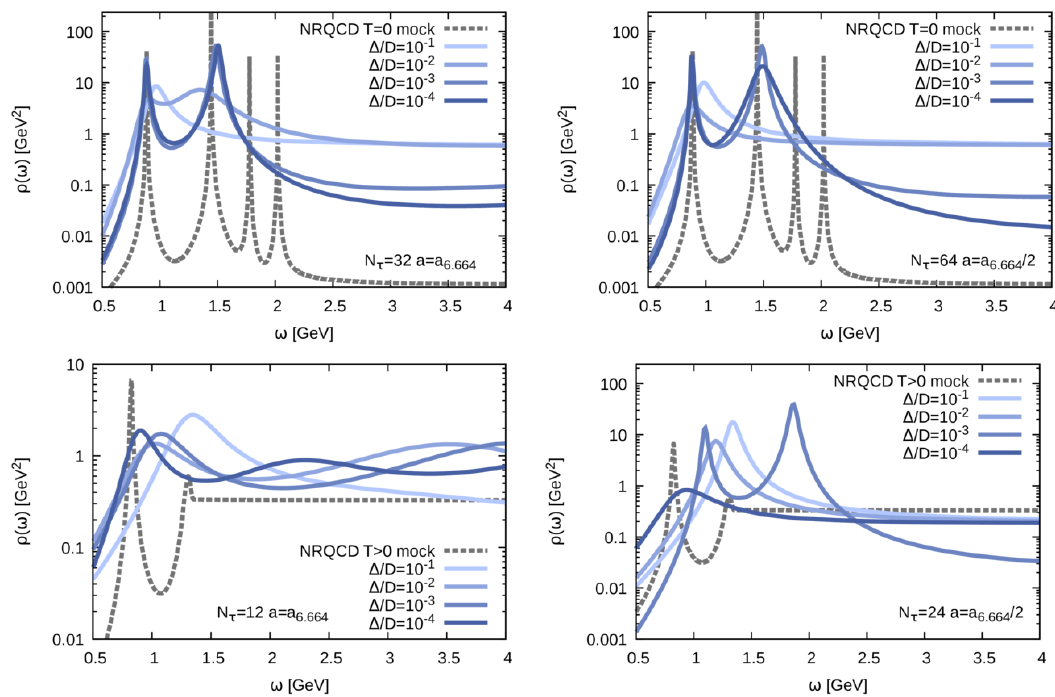
Figure 25 . Mock data tests on the prospects for improving spectral reconstruction by going closer to the continuum limit. In the top row we show a T = 0 mock test with the mock spectrum (dashed gray) consisting of four sharp Breit-Wigner peaks ordered according to the PDG (cid:7) channel masses. The lowest peak is located at the frequency found in the raw NRQCD correlator at (cid:12) = 6 : 664. in the top left panel the mock spectrum is encoded as N (cid:28) = 32 correlator with the same temporal spacing as at (cid:12) = 6 : 664. Reconstructions based on input with di(cid:11)erent relative errors are given as blue solid lines. The top right panel shows the outcome if instead a twice as small lattice spacing and N (cid:28) = 64 is used. In the bottom row a challenging T > 0 scenario is considered with a widened Breit Wigner and a small threshold enhancement. Reconstructions in the bottom right panel arise from correlator data with N (cid:28) = 12 and the same spacing as at (cid:12) = 6 : 664, while in the bottom right panel twice the resolution and N (cid:28) = 24 is